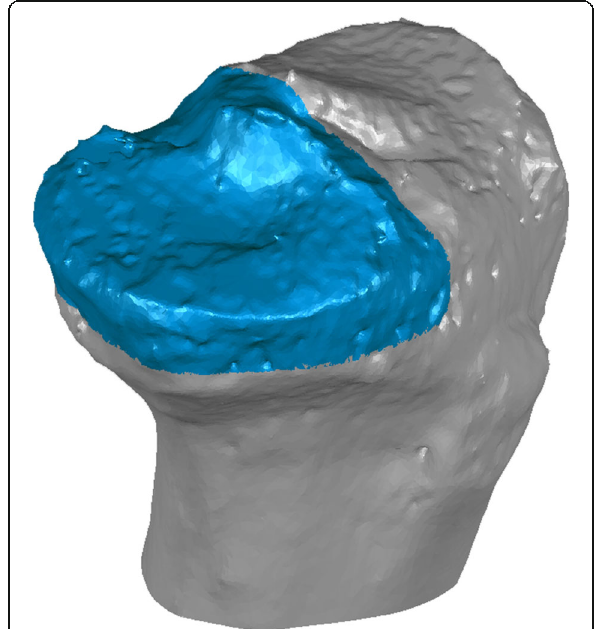
Fig. 2 Model of the medial tibial plateau. The medial plateau model (blue) and the tibial model (gray) is shown. The medial tibial model is created by cutting the original tibial bone model at the level of 10.0 mm inferior to the tibial plateau (the ZX plane) and the original XY